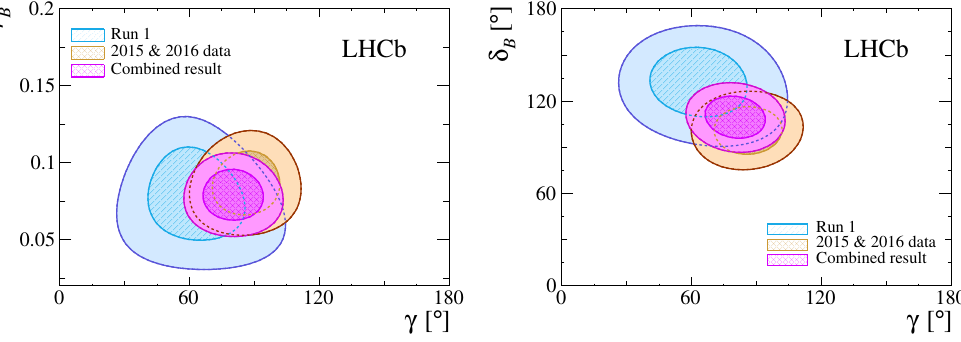
Figure 11 . Two-dimensional 68.3 % and 95.5 % con(cid:12)dence regions for ( (cid:13); r B ; (cid:14) B ) for the x (cid:6) , y (cid:6) parameters obtained in the (cid:12)t to 2015 and 2016 data, the (cid:12)t to Run 1 data, and their combinations. performing the combination while taking only subsets of the uncertainties into account. It is found that the statistical uncertainty on (cid:13) is 8 : 5 (cid:14) , the uncertainty due to